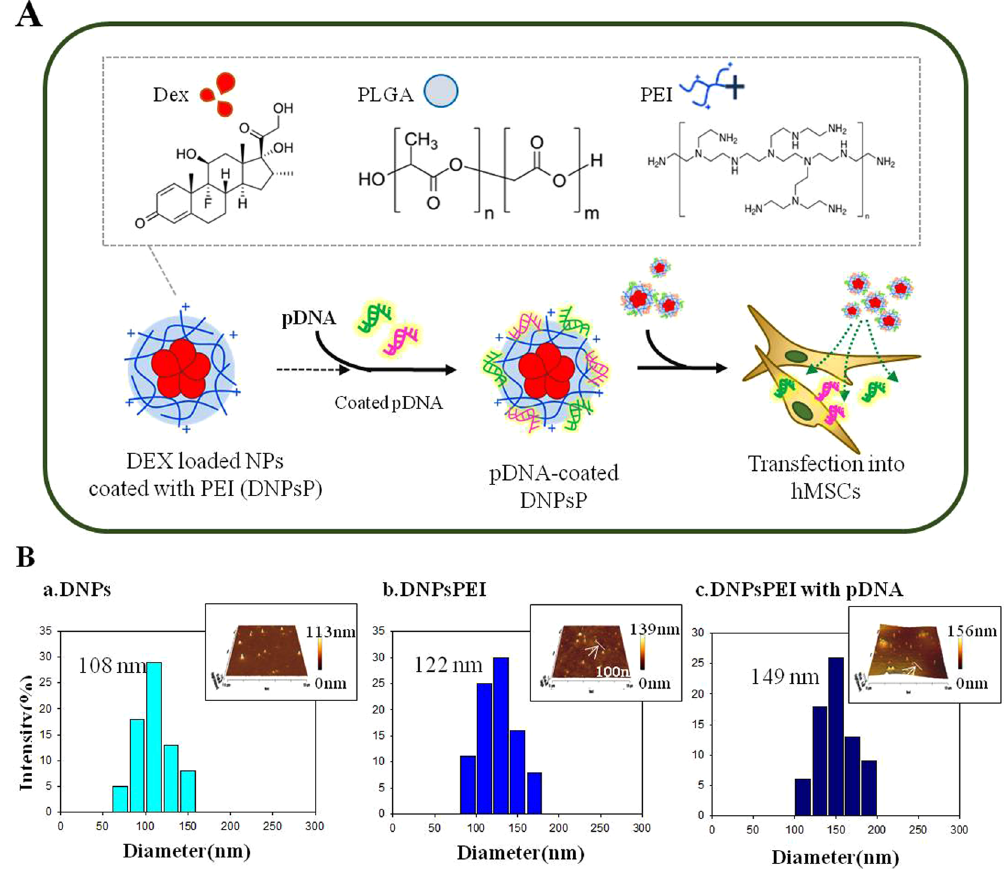
Figure 1. Characterization of dexamethasone-loaded nanoparticles (DNPs). ( A ) Schematic illustration of DNPs formation. ( B ) Size and distributiondata abtained by dynamic light scattering (DLS) and atomic force microscopy (AFM) scanning. (a) DNPsP, (b) DNPsP with